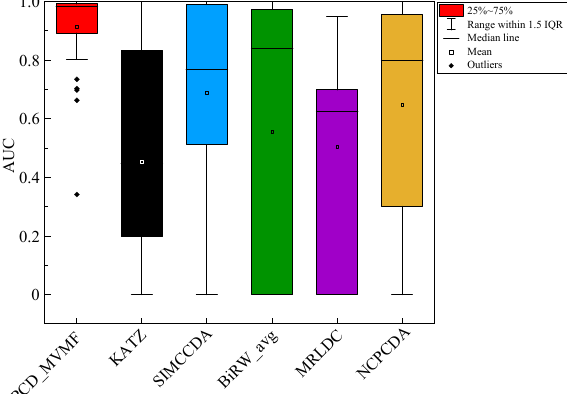
Fig. 4 Average precision of the test set at each Top- k position on querying diseases.